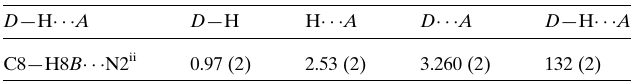
Table 3 Hydrogen-bond geometry (A˚ , (cid:2) ) for 1 .